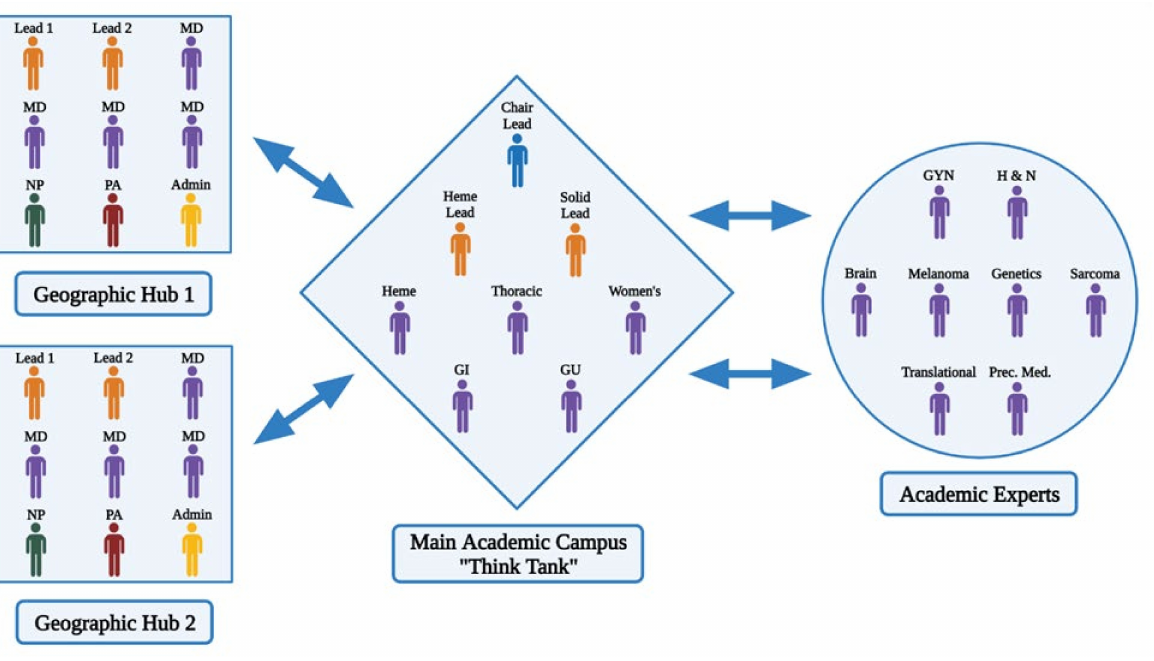
Figure 2. Complex Oncology Case Discussion: community practice hub and academic site ‘think tank’ integration of